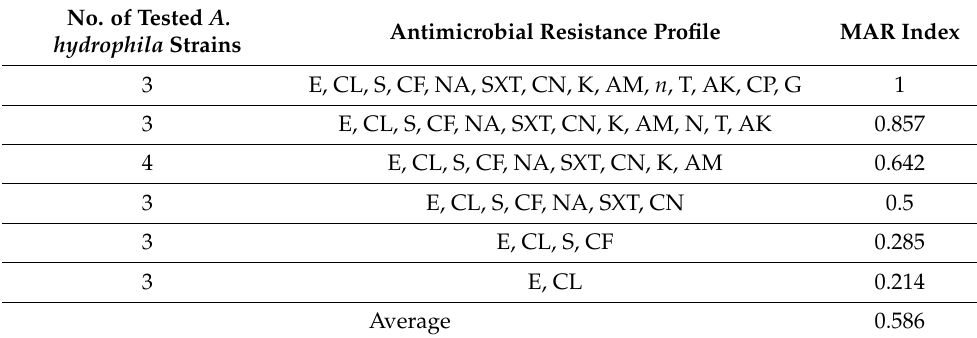
Table 4. Antibiotic resistance profile and MAR index of A. hydrophila isolated from Nile tilapia ( n * = 19). No. of Tested A. Antimicrobial Resistance Profile MAR hydrophila Strains